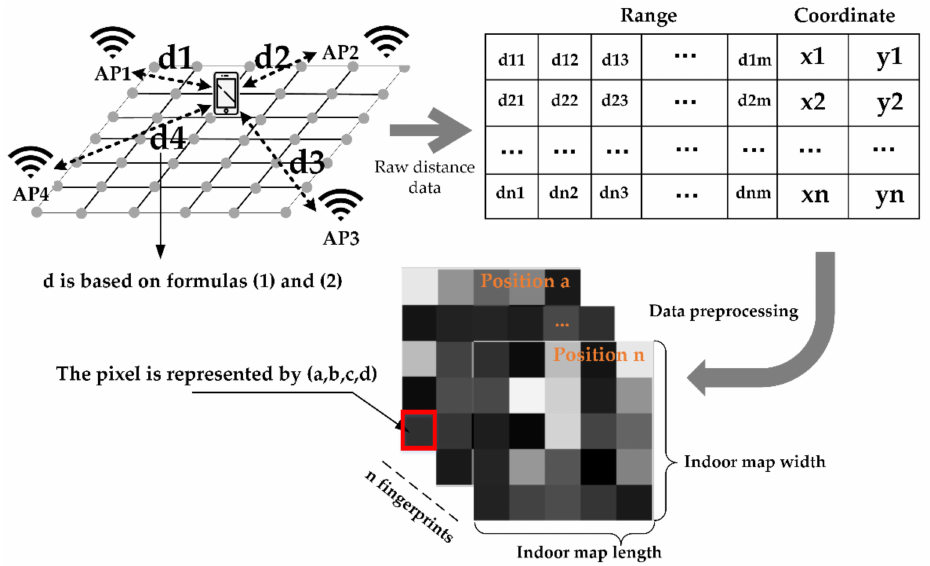
Figure 5. Dataset construction